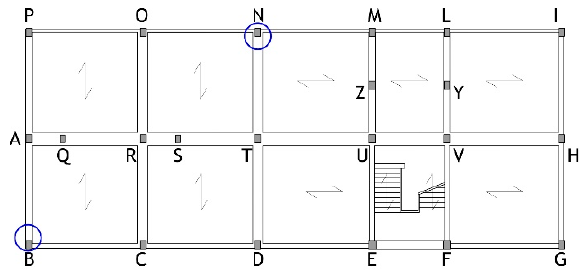
Figure 23. Numbering of beam-to-column joints.